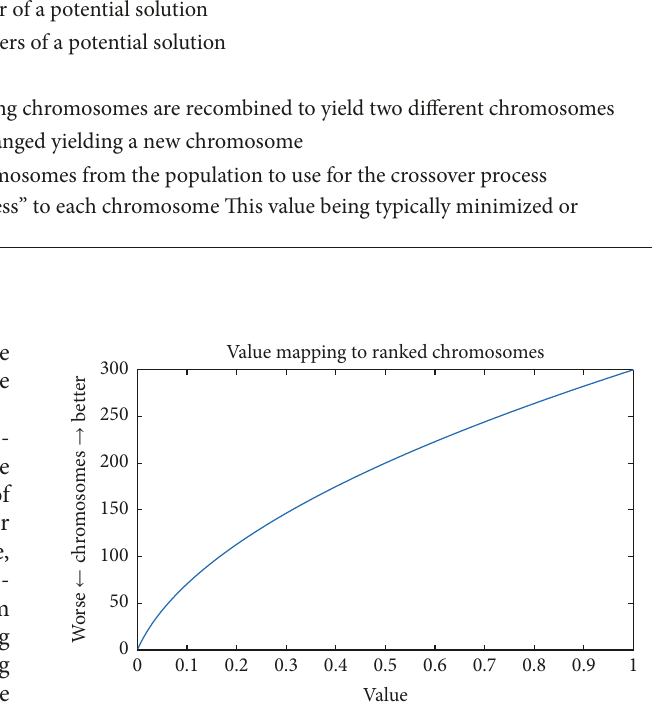
Figure 2: The mapping of the selection value to the ranked chromo- somes. When testing from bottom to top, the first chromosome to have a higher value than a randomly generated number in the range (0, 1) is selected.